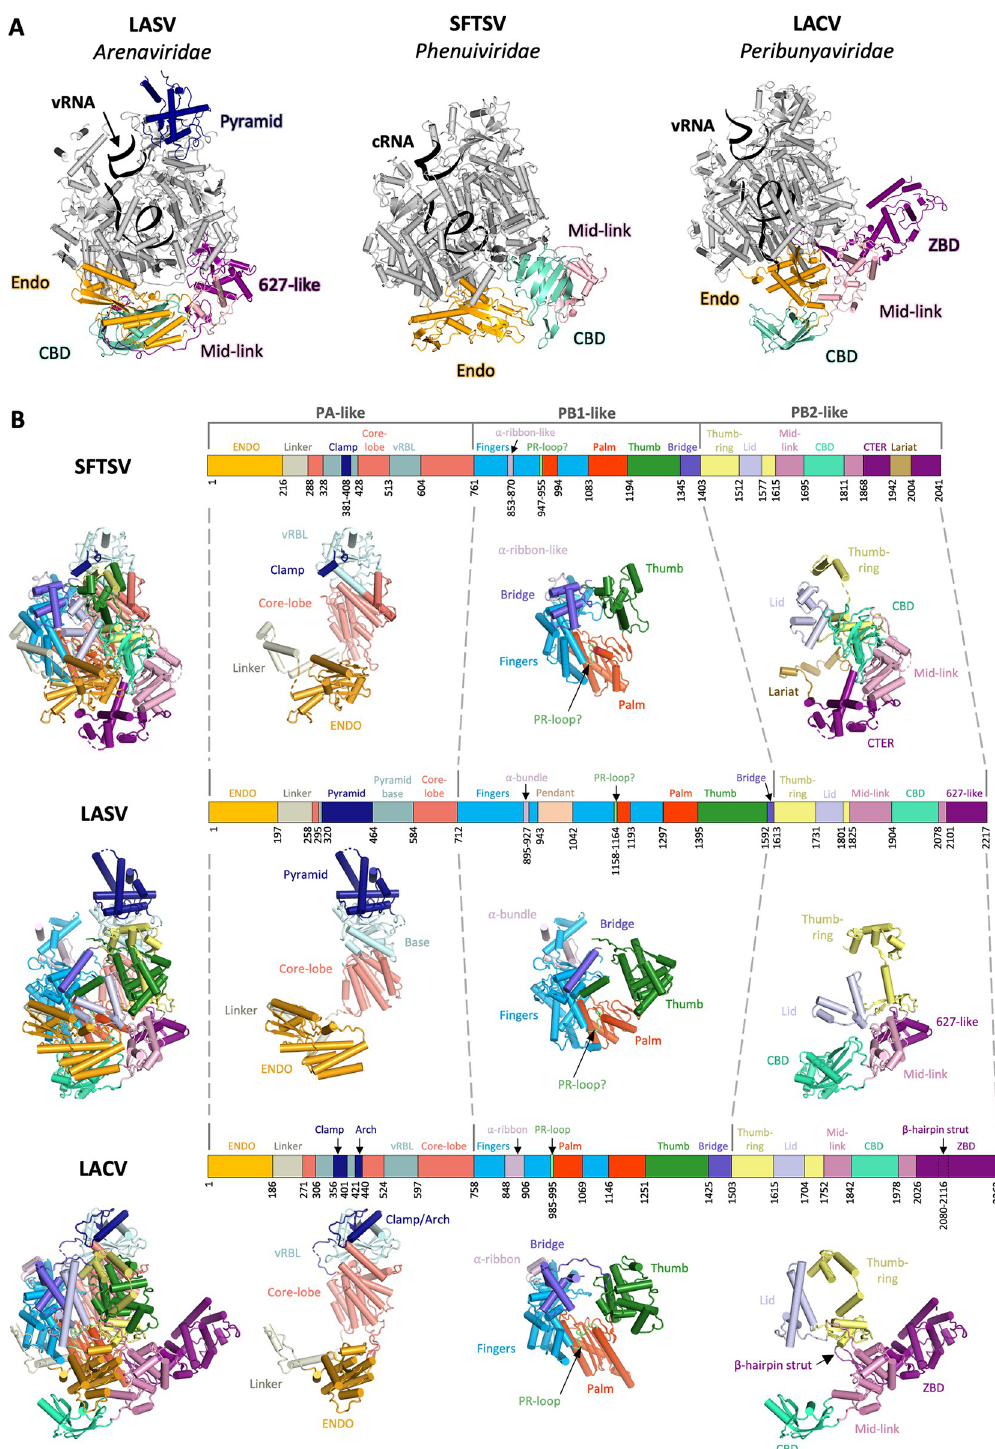
Fig 2. Structural comparison of LASV, SFTSV, and LACV L proteins. (A) The LASV late-elongation (PDB: 7OJN) [48], SFTSV late-elongation (PDB: 8ASD) [50], and LACV early-elongation (PDB: 7ORM) [49] L protein structures are shown side by side. The core of each L protein is shown in grey with key domains colored as follows: endonuclease (orange), pyramid domain (only in LASV, dark blue), CBD (cyan), mid-link domain (pink), and 627-like/zinc-binding domain (purple). Bound RNAs are shown as black ribbons. (B) The LASV late-elongation (PDB: 7OJN,) [48], SFTSV apo structure (PDB: 7ALP) [42],